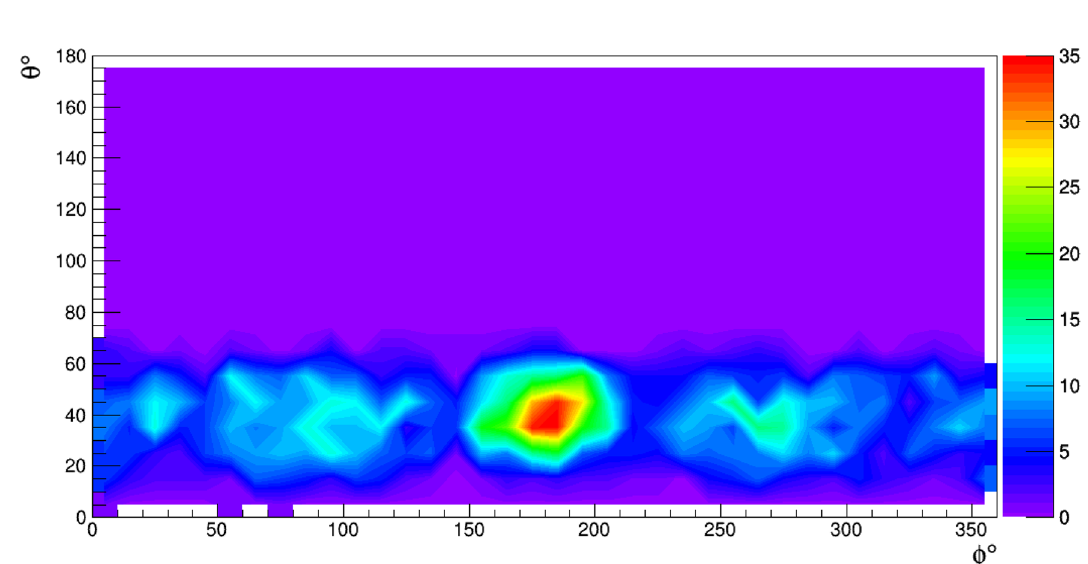
Figure 7. Number of muons (in arbitrary units) as a function of the zenith angle θ and azimuthal angle φ observed by the detector in the case of a cavity of 15 m radius, located at a depth of 20 m with the detector at depth of 40 m and a distance of 25 m in the horizontal plane. The center of the cavity has azimuth 180 ◦